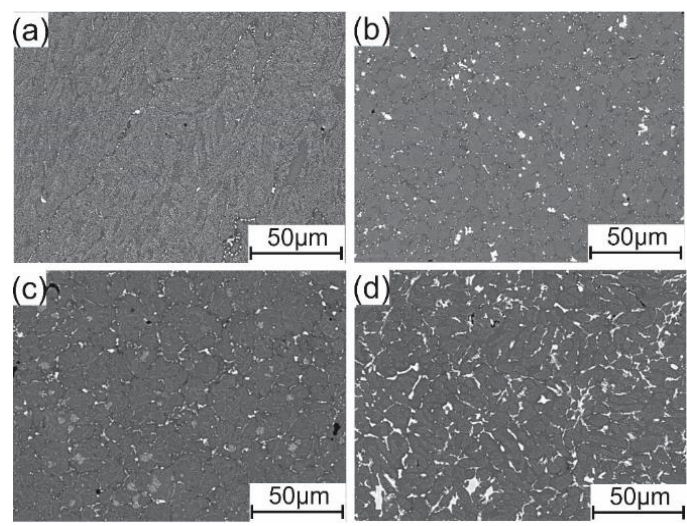
Figure 4. SEM microstructure of Al–Zn–Mg–Cu alloy after homogenization annealing at 460 °C for 3 h: ( a ) Standard alloy, ( b ) with the addition of Sc and Zr, ( c ) with the addition of Ti and B, and ( d ) with the addition of Fe and Ni.